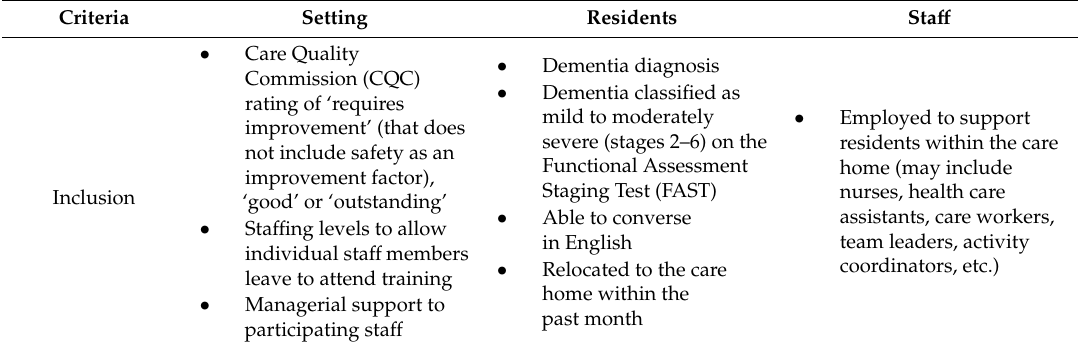
Table 2. Inclusion